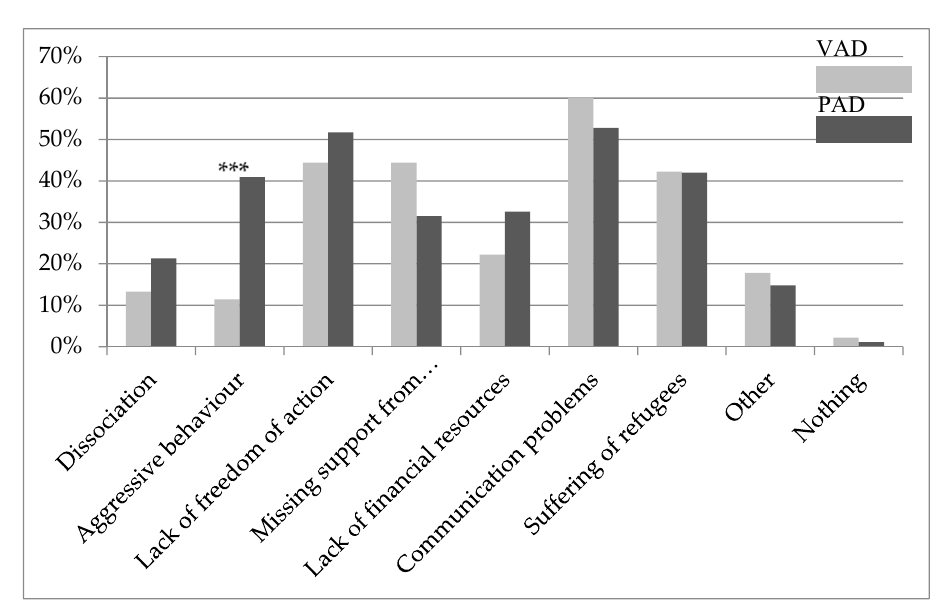
Figure 3. Burdens in refugee work for VAD and PAD. Multiple answers possible; other = e.g., this is my job; intercultural interest; *** p < 0.001.